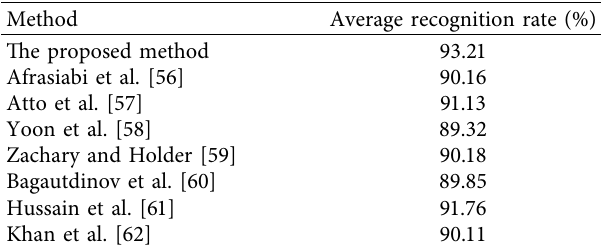
Table 3: Compared with other approaches on the Vlog dataset and AVA dataset.